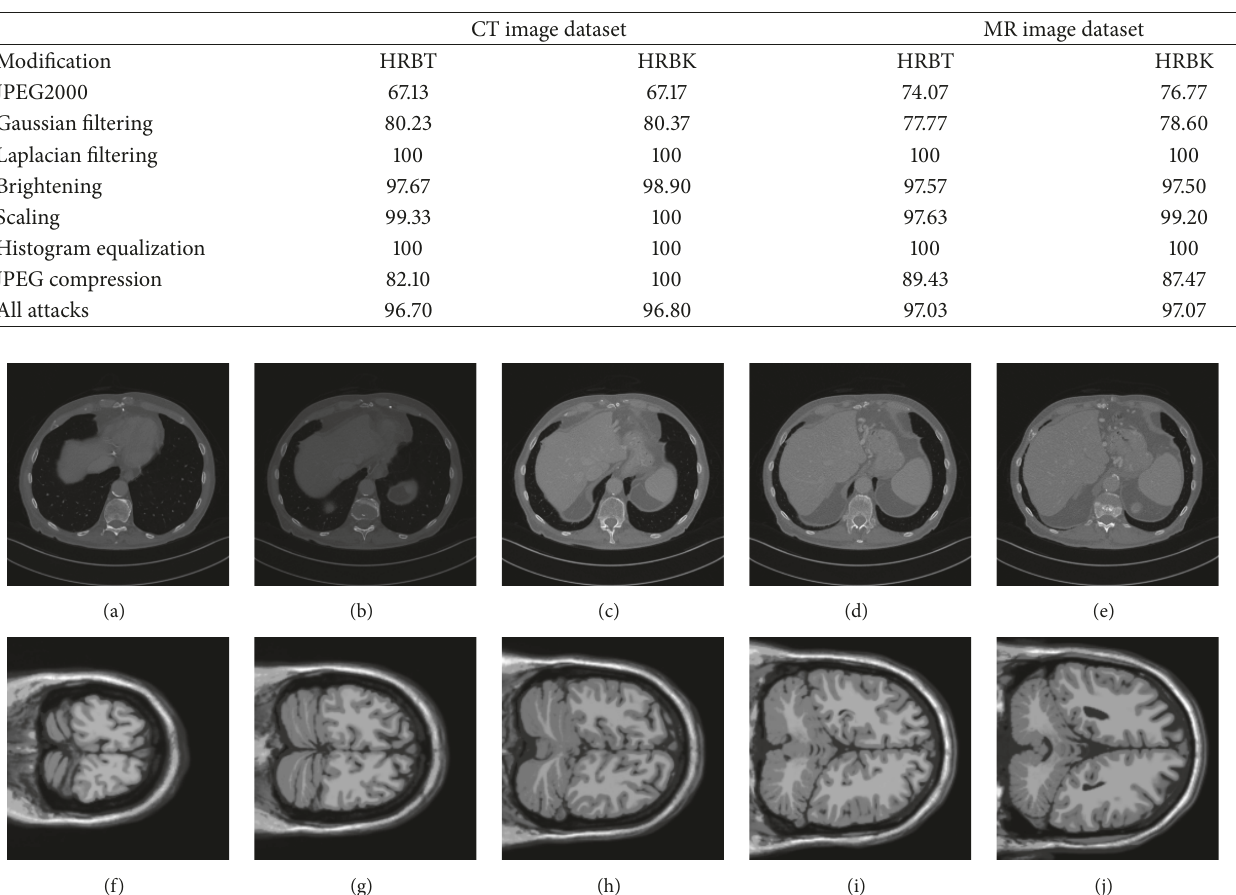
Table 2: Modification detection rates (%) with HRBT and HRBK features.